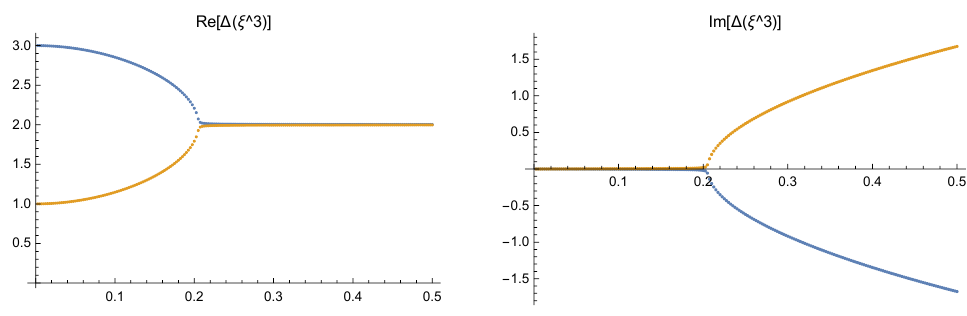
) as a function of the 1